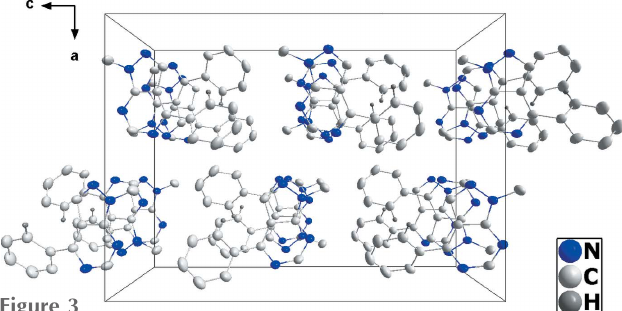
Figure 3 Packing viewed along the b direction. H atoms have been omitted for